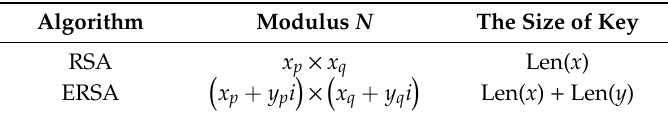
Table 1. Details of N and the key size of RSA and ERSA.